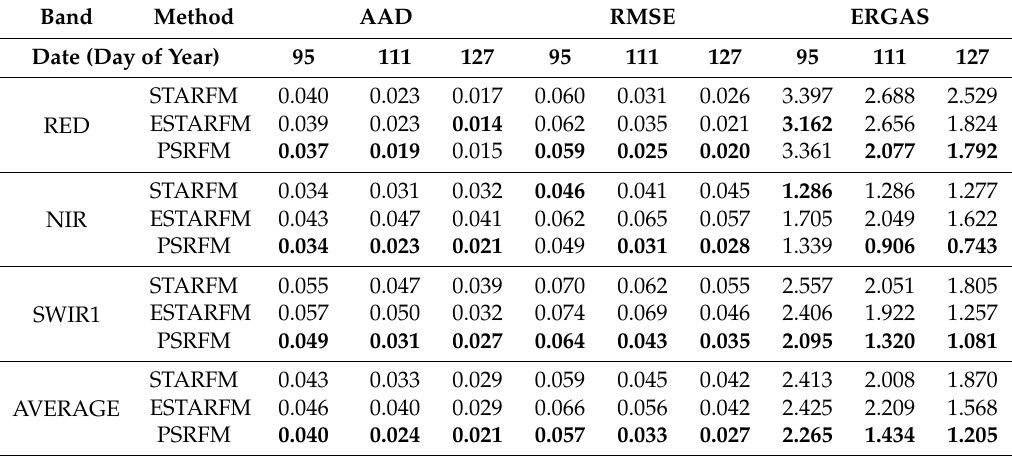
Table 2. Quality indices AAD, REMS and ERGAS of the predicted Landsat-like image time series by the three models STARFM, ESTARFM and PSRFM.